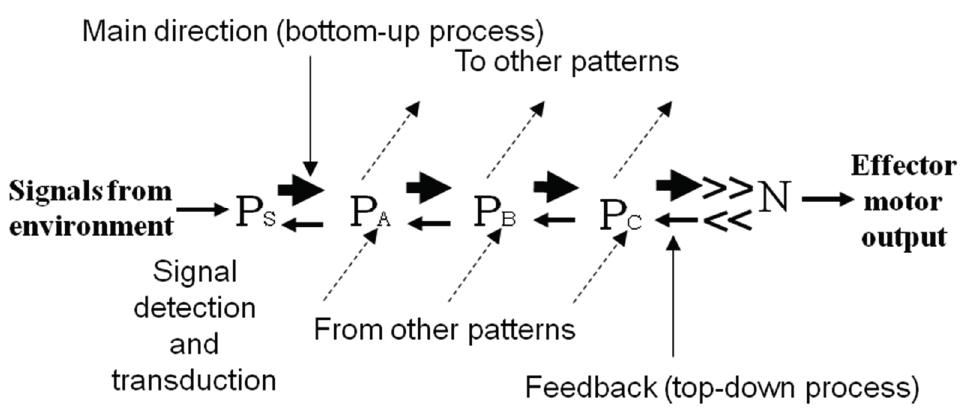
Figure 1. Bottom-up process of perception and top-down process of mental imagery hypothetically explained by pragmatic information, Based on Roederer [13] (p.